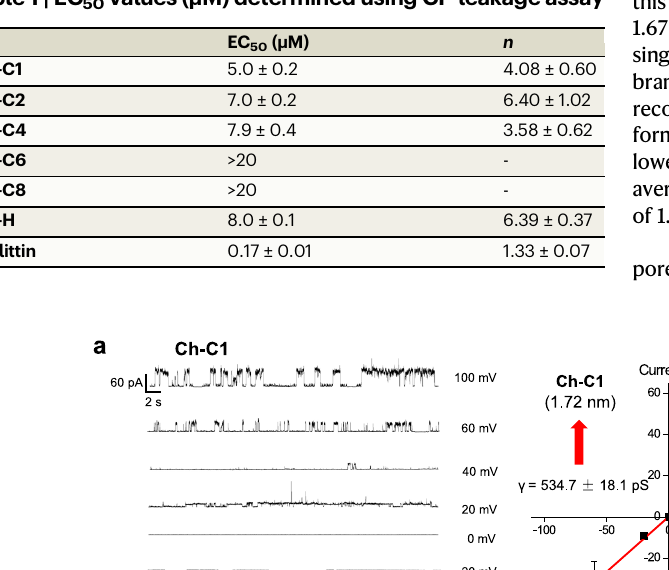
are represented as meancurrent values ±half width at half maximum. n = 3 inde- pendentexperiments. c Moleculardynamics-simulatedpore-formingensemblesof different sizes made up of channel ( Ch-C1 or Ch-C4 in yellow) and Ch (in blue) molecules in 1:1 molar ratio. d An alternative self-assembling possibility involving Ch-C1 and Ch in 1:2 molar ratio to generate a pore of